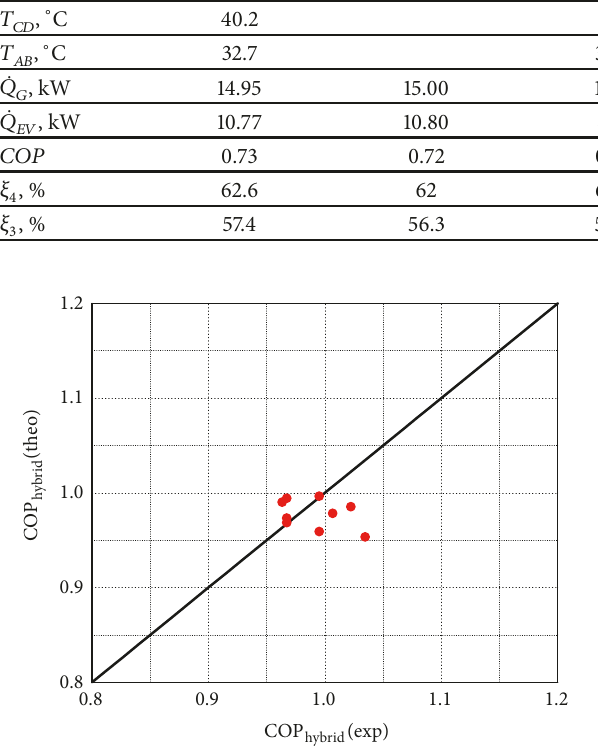
Figure 3: Hybrid cycle model validation basing on experimental data of ref.